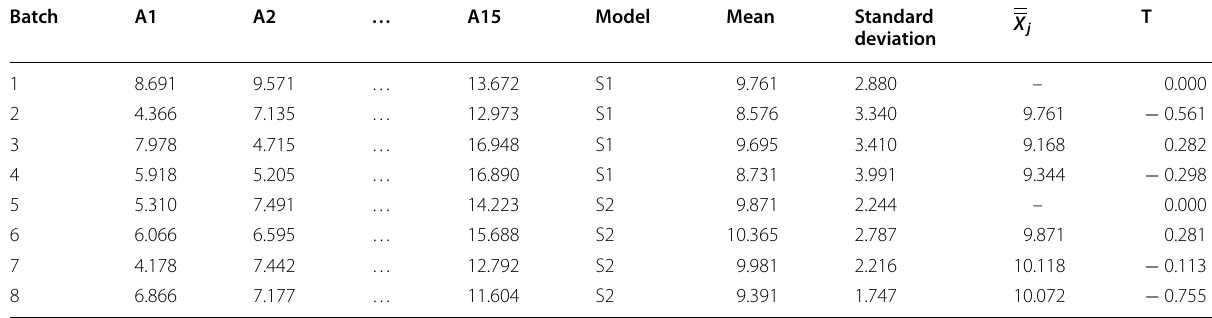
Table 9 Calculation results of T-statistic